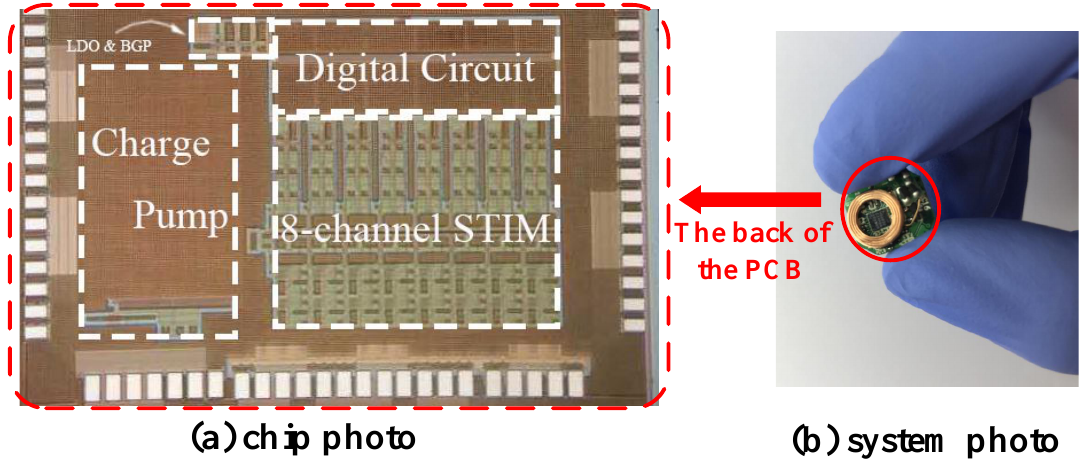
Figure 10. ( a ) Microphotograph of the proposed IC. The silicon area of the proposed chip is 1.5 mm × 2.5 mm. ( b ) Photograph of the proposed prototype system implemented using the described ASIC chip. The size of the proposed system is 14 mm × 14 mm × 3 mm excluding the